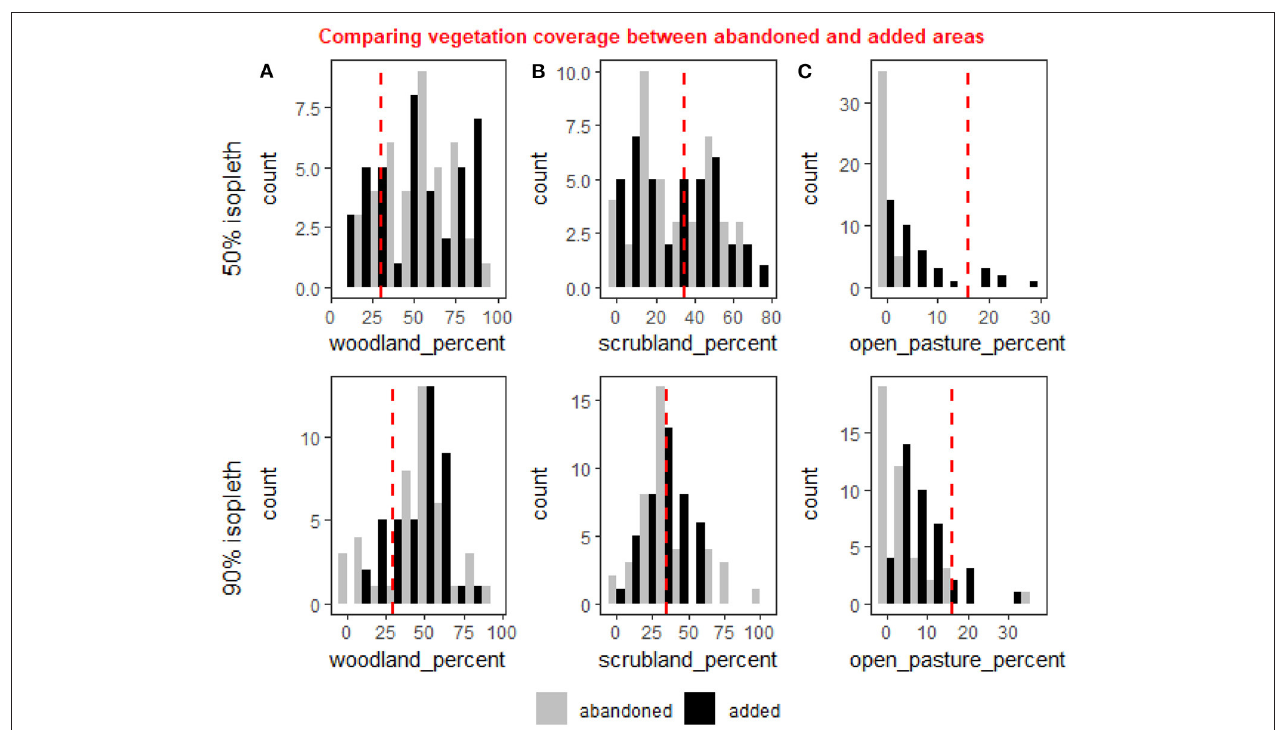
FIGURE 4 | A comparison of the distribution of coverage the three vegetation cover types—woodland (A) , scrubland (B) and open pasture (C) —between area of the first year’s home range that were abandoned relative to the last (gray), and the areas added to the last year’s home range relative to the first (black). The comparison is for the 50% isopleth (core of the home range—upper row) and the 90% isopleth (entire home range—lower row). The red line represents the average coverage in the study area. Percent open pasture was significantly higher in the added areas compared to the abandoned ones for both the 50 and 90% isopleths (weighted t -test: p < 0.001 for both). There were no significant changes in the woodland and scrubland, but the increase in open pastures appear to be on account of a minor (albeit non-significant) decline in the